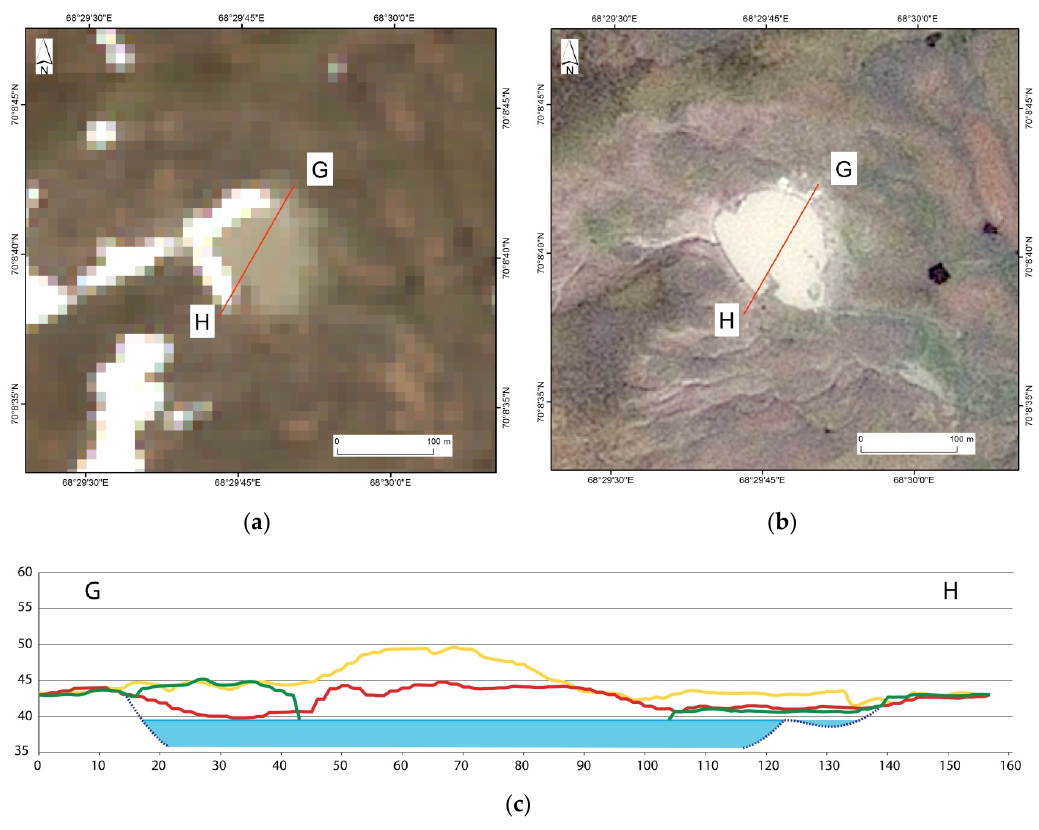
Figure 9. Validating the reliability of a “mound” observed in the GEC-2 location using ArcticDEM Stripe of 2016: ( a ) Surface conditions on June 16, 2016, based on Sentinel-2 image; ( b ) Surface conditions on July 15, 2016, based on SPOT6 image; ( c ) Elevation profiles: the red line is the surface plotted using ArcticDEM Stripe extracted from a June 16, 2016 imagery; the yellow line is the mound-predecessor surface “before” GEC formation extracted from multi-temporal stereo pair of 2010–2011 (Table 1); the green line is the surface “after” GEC formation on July 21, 2013 (Table 1); water surface boundaries are shown as of SPOT6 image dated July 15, 2016.